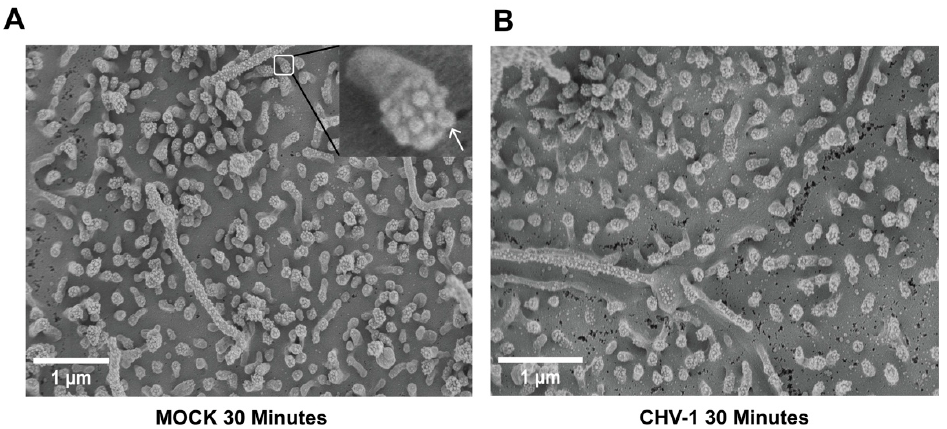
Figure 3. Ultrastructure of lamellipodia at the apical surface of polarized MDCK cells is not altered upon CHV-1 entry. Electron micrographs showing MDCK cells polarized on transwell inserts that have either been mock-infected for 30 min ( A ) or infected with CHV-1 for 30 min ( B ). Magnification was 20,000×. In ( A ), a section of the image is enlarged to show a single lamellipodium; an arrow points to one of the protrusions at the tip of the lamellipodium. Results shown are representative images from one of two independent experiments.